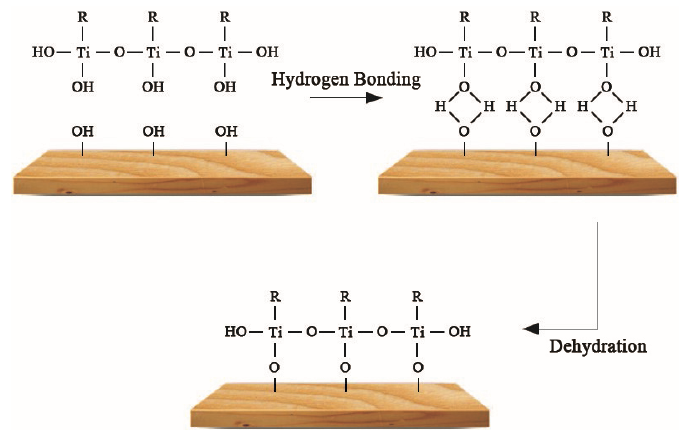
Figure 10. γ -(2,3-epoxypropoxy)propytrimethoxysilane (KH560) bonding the wood surfaces.